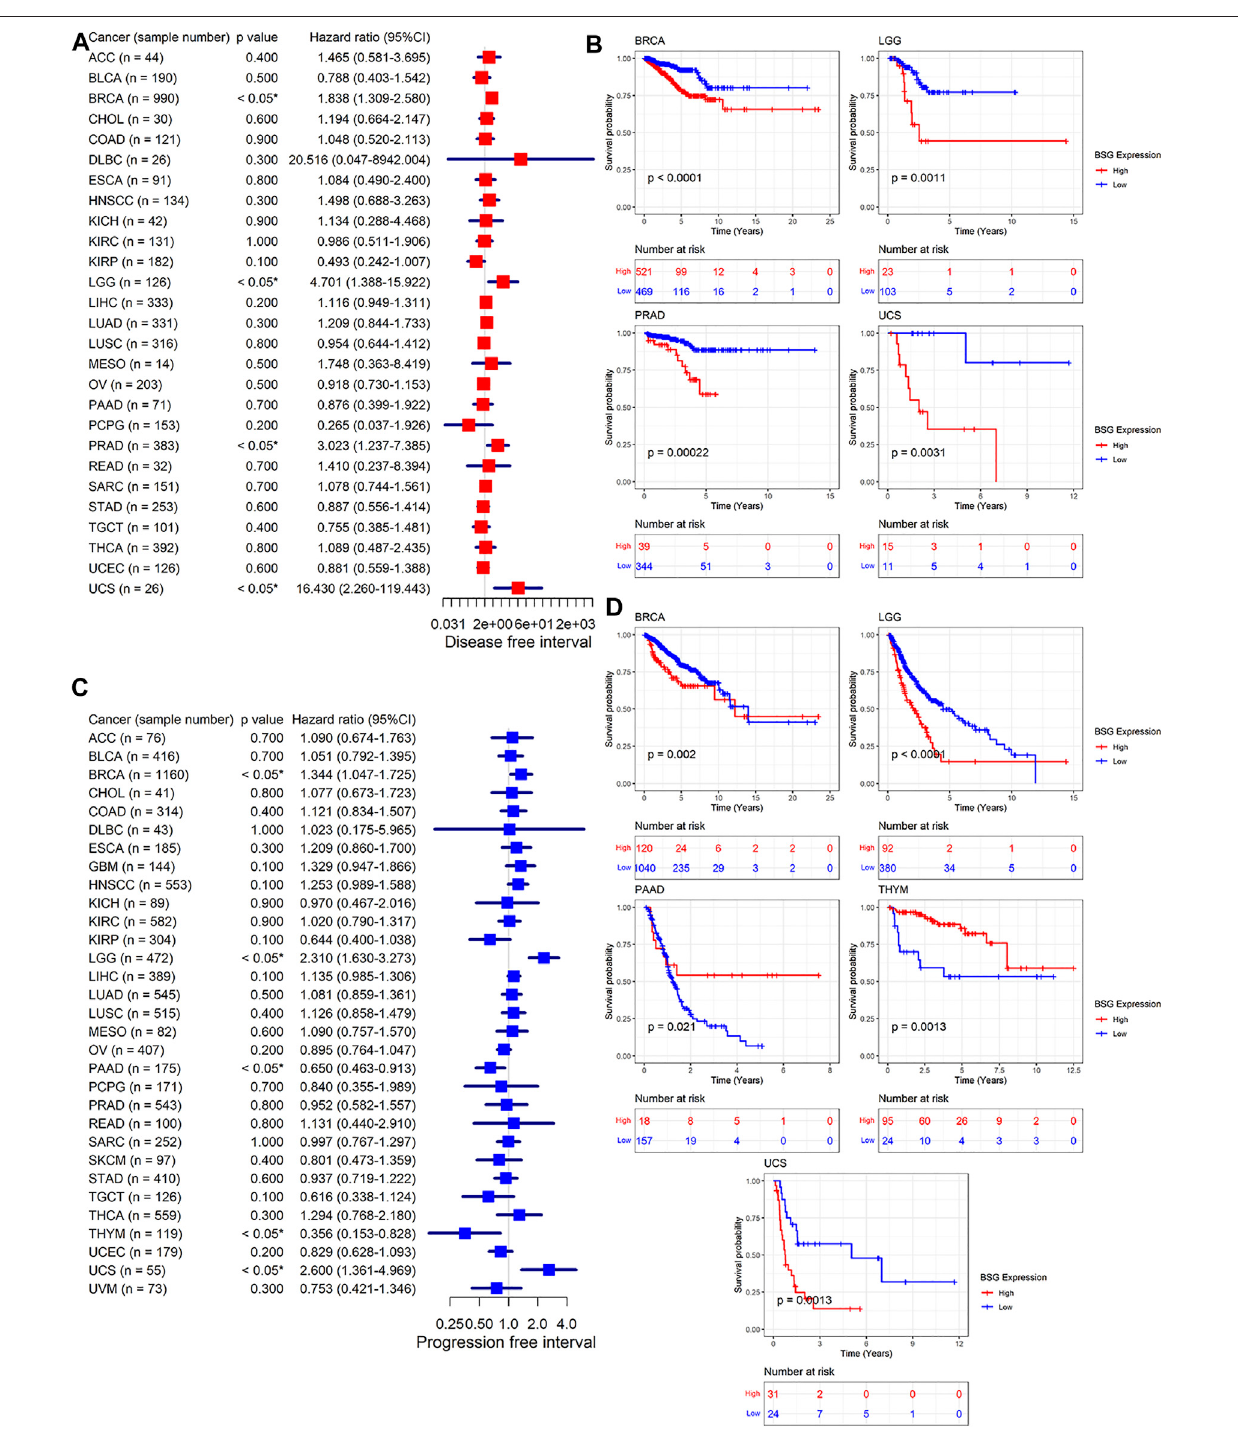
FIGURE 5 | Relation of BSG expression with disease-free survival (A – B) and progression-free survival of cancer patients (C – D) . (A,C) Forest plots produced by univariate Cox regression analysis. (B,D) Kaplan – Meier curves with p -values based on log-rank tests. The optimal cut point for high and low expression levels of BSG in each Kaplan – Meier curve was identi fi ed using the maximally selected rank statistics from the “ maxstat ” and “ survminer ” R packages. In (A,C) , the value in parentheses (e.g., “ n = 44 ” for ACC) represents the number of samples. ACC, adrenocortical carcinoma; BLCA, bladder cancer; BRCA, invasive breast carcinoma; CHOL, cholangiocarcinoma; COAD, colon adenocarcinoma; DLBC, lymphoid neoplasm diffuse large B-cell lymphoma; ESCA, esophageal carcinoma; GBM, glioblastoma multiforme; HNSCC, head and neck squamous cell carcinoma; KICH, kidney chromophobe; KIRC, kidney renal clear cell carcinoma; KIRP, kidney renal papillary cell